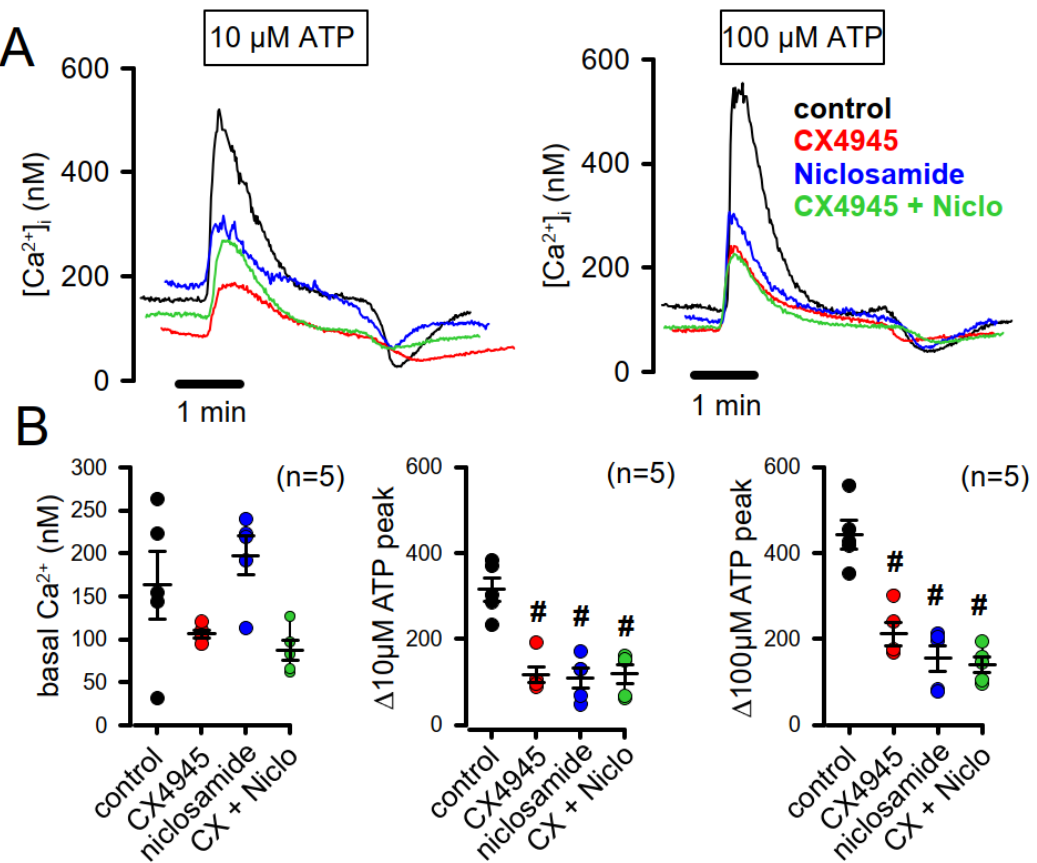
Figure 6. Blockers of CK2 and TMEM16A inhibit receptor-mediated Ca 2 + signaling. ( A , B ) Original recordings and summaries for basal and ATP-induced intracellular Ca 2 + concentrations in Cal33 cells. Increase of intracellular Ca 2 + by 10 and 100 µ M ATP, respectively. Both CX4945 (20 µ M; #significant inhibition, ANOVA; p = 0.0004) and niclosamide (1 µ M; #significant inhibition, ANOVA; p = 0.0002) largely reduced ATP-induced Ca 2 + increase. Mean ± SEM. In parentheses are numbers of experiments.